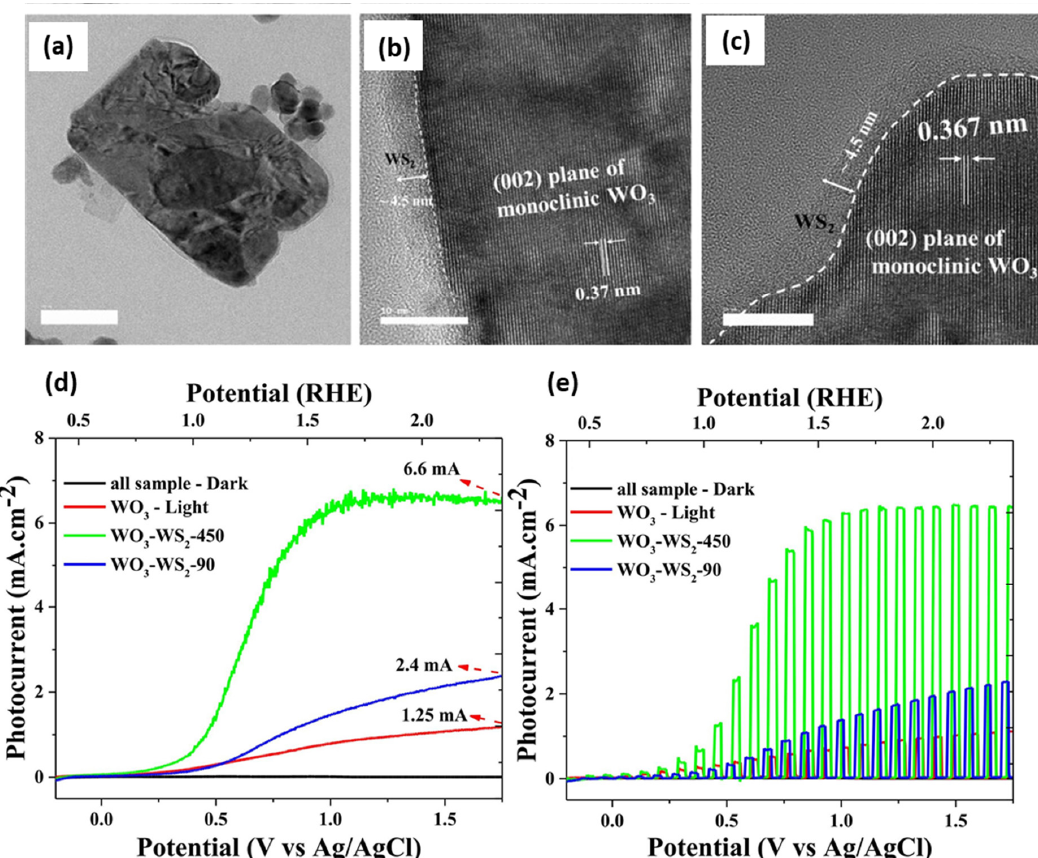
Figure 15. ( a ) Low magnification, ( b , c ) high-resolution TEM images of WO 3 /WS 2 heterostructures. ( d ) LSV and ( e ) chopped scan voltammetry at 1.75 V (vs. Ag/AgCl) for WO 3 and WO 3 /WS 2 heterostructures photoelectrodes. Reproduced with per ‐ mission. [150] Copyright 2021, Elsevier.